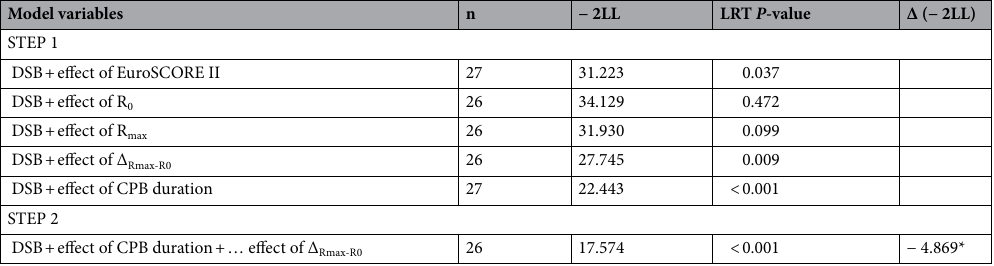
Table 3. Determination of explanatory variables in a logistic model for DSB. * P < 0.05, ∆(− 2LL) > 3.84. CPB cardiopulmonary bypass, DSB difficult separation from bypass, − 2LL objective function (−